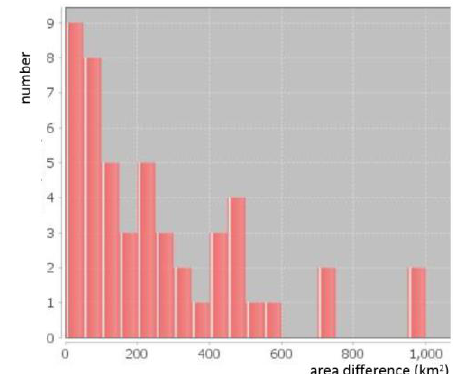
Fig 8 Frequency distribution of the area difference between multiple collected polygons and a reference